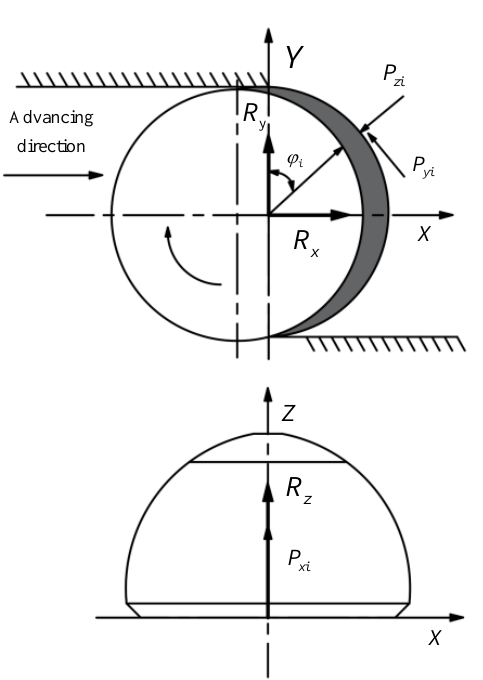
Figure 3. The cutting path of the cutting head.